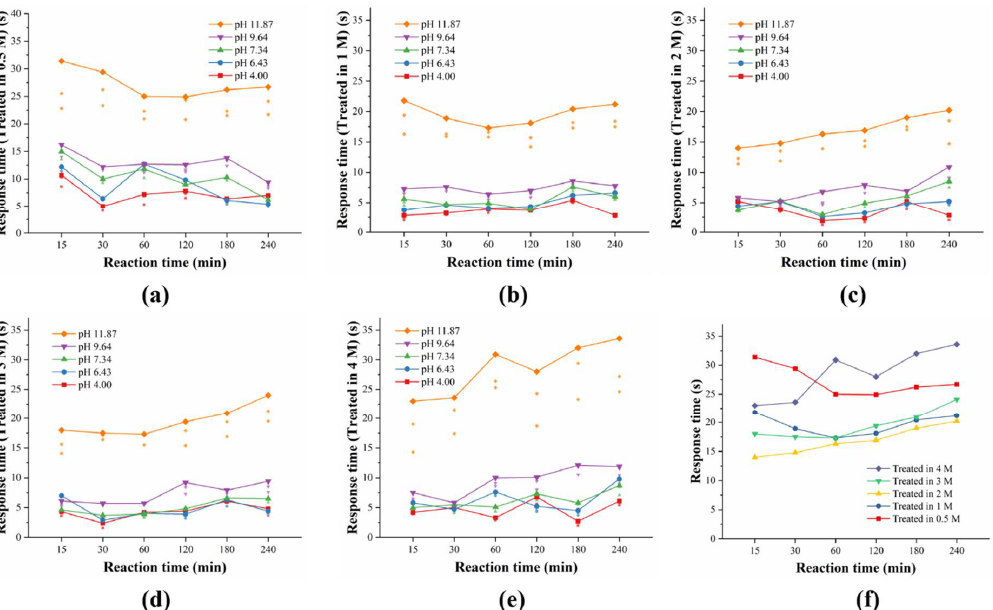
Figure 8. The influences of the fabrication parameters and pH levels on the response time of the sensitive electrodes treated in ( a ) 0.5 M, ( b ) 1 M, ( c ) 2M, ( d ) 3M, ( e ) 4M and ( f ) the response time of sensitive electrodes treated in ( a ) 0.5 M, ( b ) 1 M, ( c ) 2 M, ( d ) 3 M, ( e ) 4 M and ( f ) the response time of each electrode. each electrode.